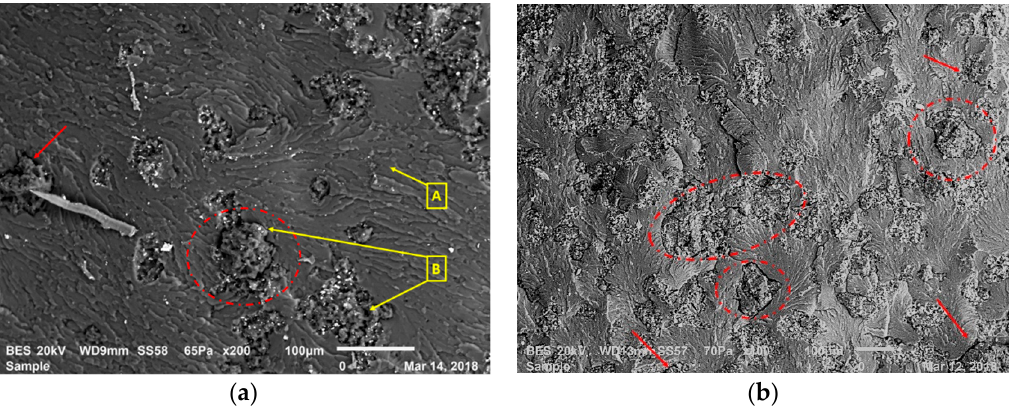
Figure 3. Comparison of the fracture surfaces: ( a ) 10% rubber-consisting composition—LR1G0.5; ( b ) 30% rubber-consisting composition—LR3G0.5.